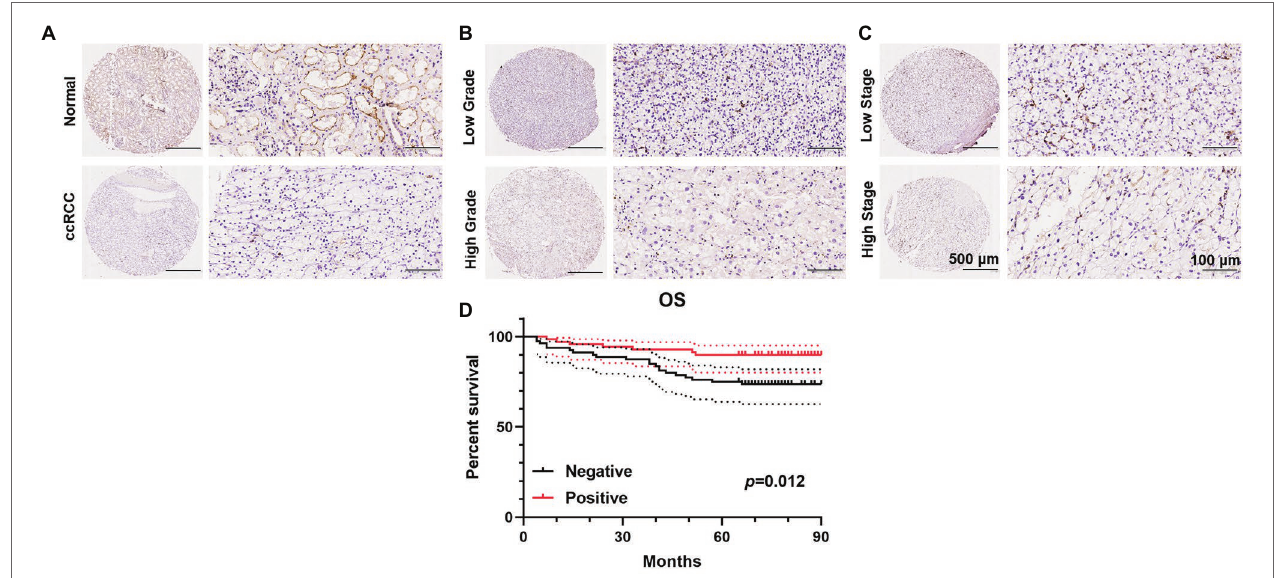
FIGURE 4 | Immunohistochemical detection of PATJ protein in 150 ccRCC vs. normal tissues. The TMAs containing 150 ccRCC and 30 normal renal tissue specimens were immunostained with an anti-PATJ antibody and quantified. Representative fields of view (FOV) show the TMA cores of PATJ expression. (A) PATJ expression in normal renal specimens vs. ccRCC. (B) PATJ expressions in low grade vs. high grade ccRCC. (C) PATJ expressions in low stage vs. high stage ccRCC. (D) Patients with negative PATJ expression showed a significantly shorter OS than patients with positive PATJ expression (Log-rank test).